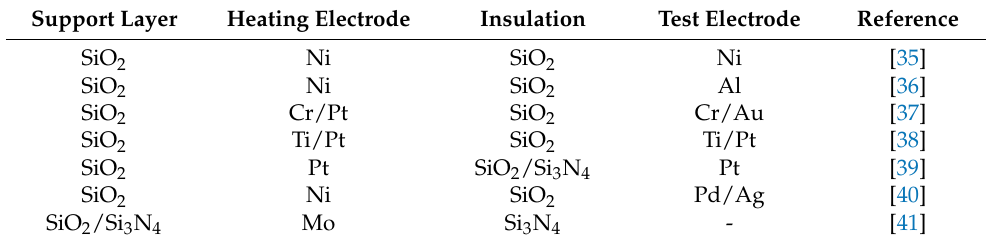
Figure 1. Silicon micro-hotplate [34]. Table 1. Silicon-based micro-hotplates material parameters. Support Layer